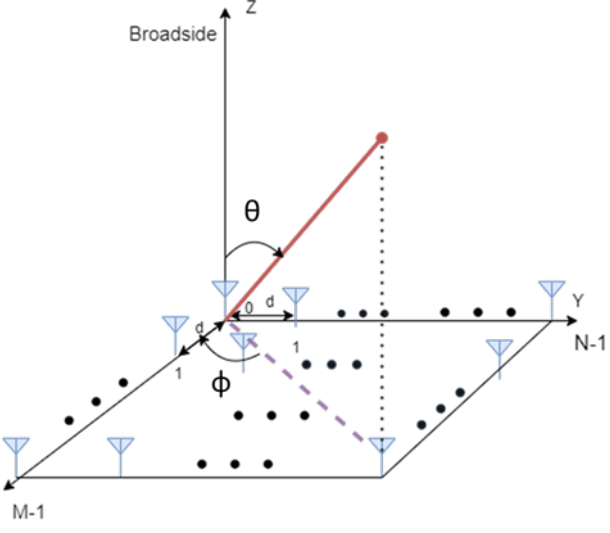
Figure 1. A uniform planar array antenna